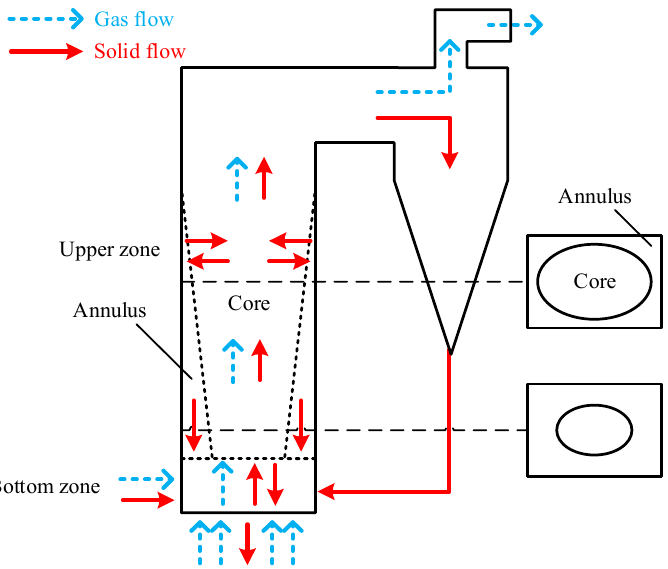
Figure 1. Diagram of “core-annulus” in CFB boiler.